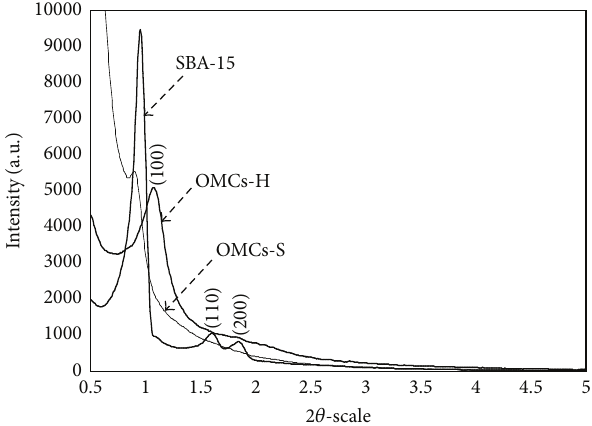
Figure 1: XRD patterns of SBA-15, OMCs-H, and